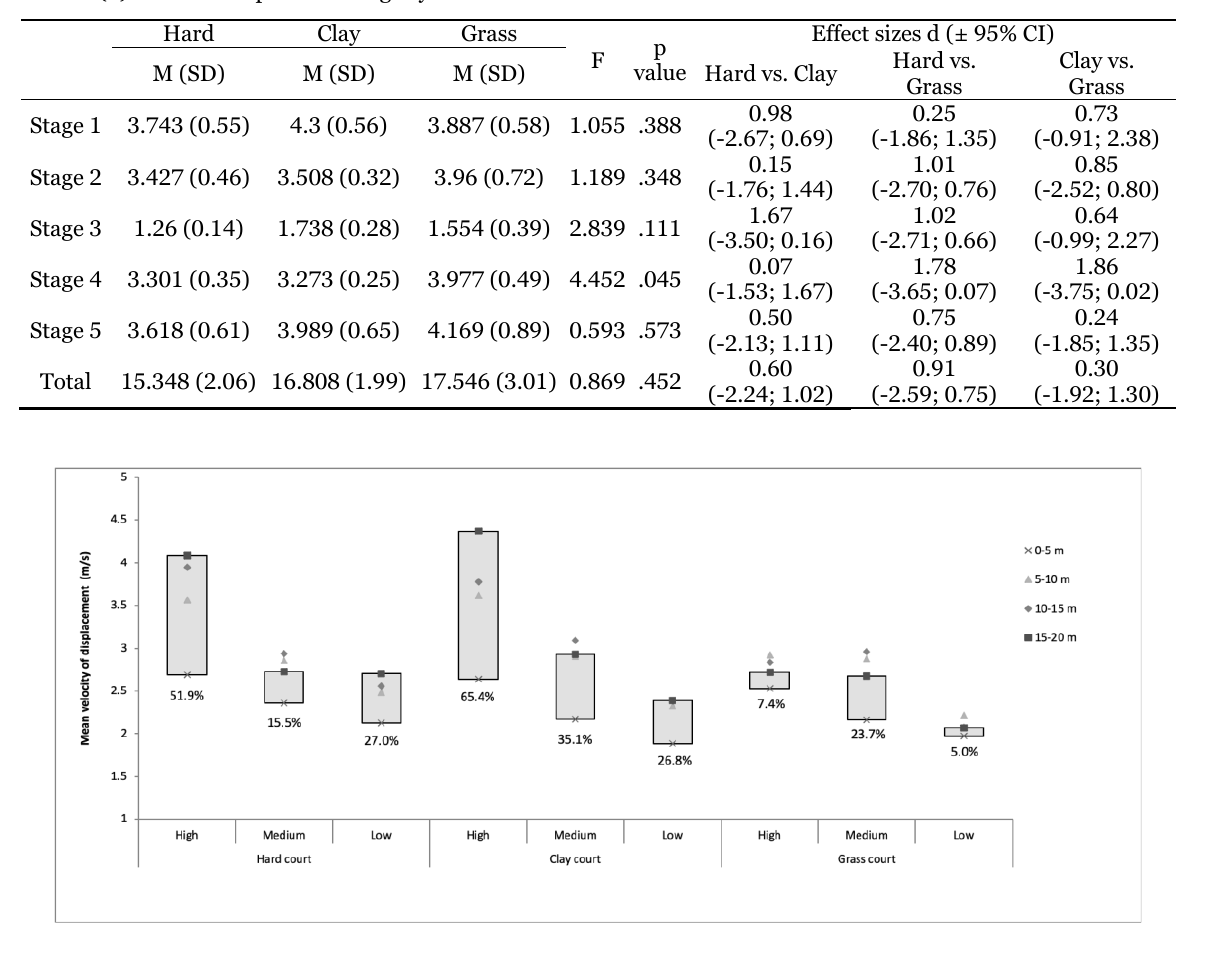
Table 4 . Mean (M), standard deviation (SD) in seconds, statistical differences (p) and effect sizes (d) of the time spent in the agility t-test.